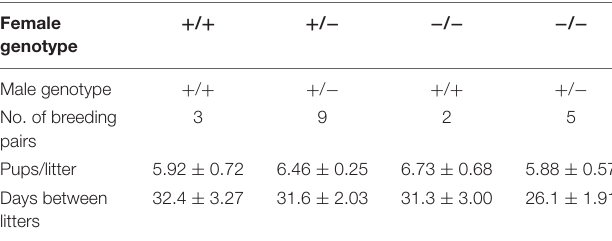
TABLE 1 | Breeding efficiency of Abhd2 − / −